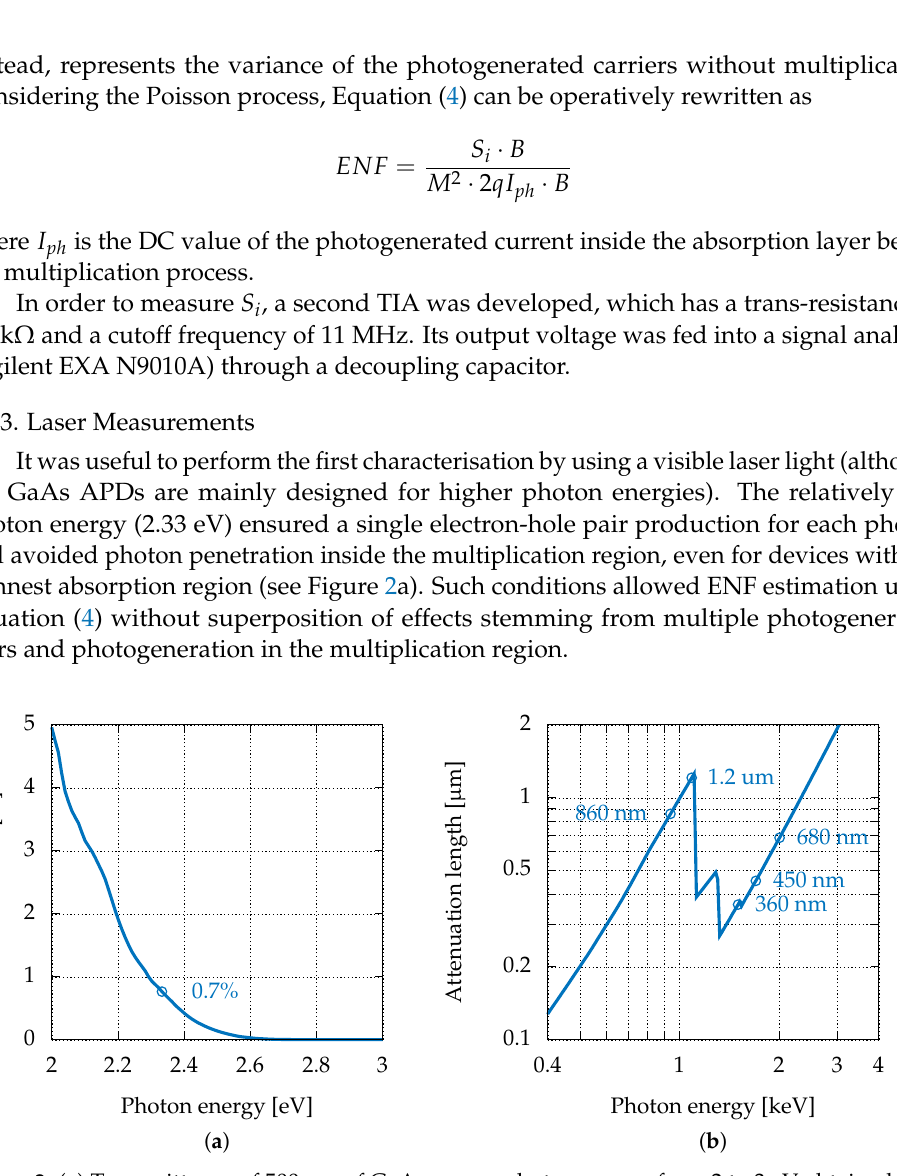
Figure 2. ( a ) Transmittance of 500 nm of GaAs versus photon energy from 2 to 3 eV obtained with IMD software [42]. ( b ) Attenuation length in GaAs versus X-ray energy from 400 eV to 4 keV [43]. The marked points indicate the energies at which the measurements were